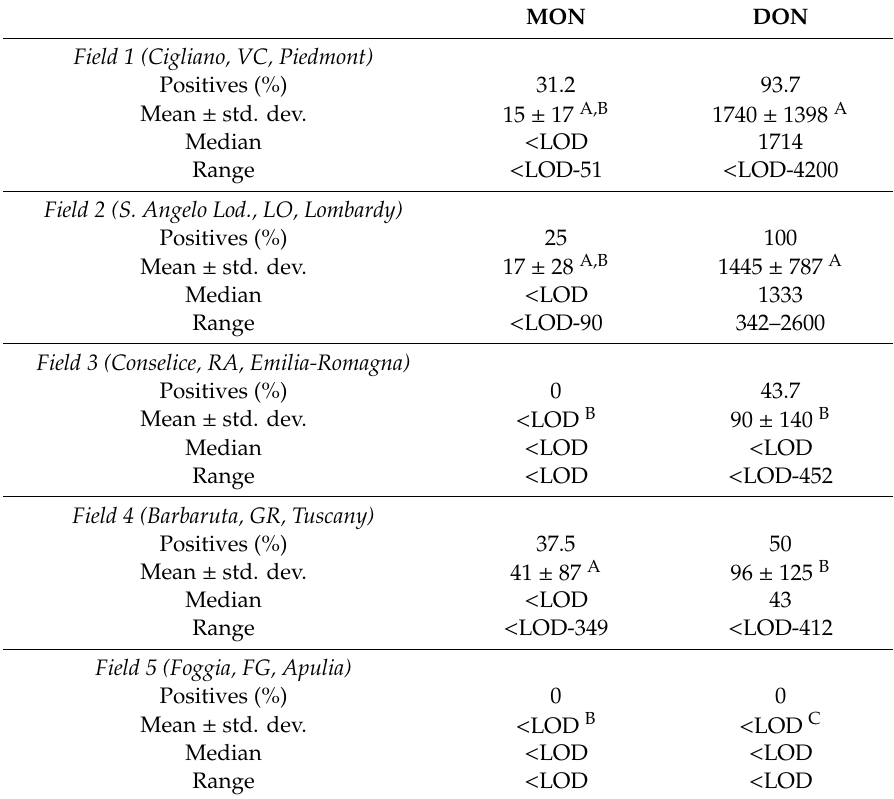
Table 3. Descriptive statistics of moniliformin (MON) and deoxynivalenol (DON) contamination ( µ g kg − 1 ) for common wheat samples collected in Italy in 2019.